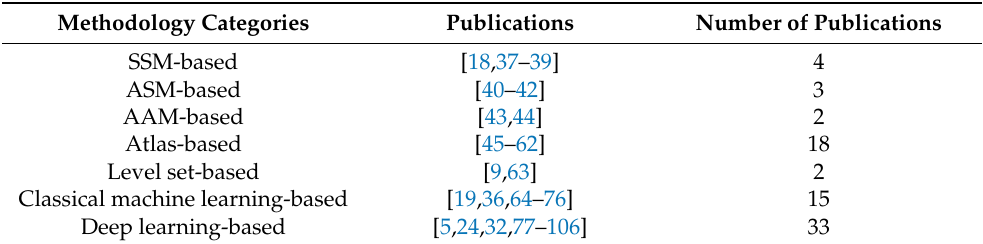
Table 2. Methodology applied to automatic mandible segmentation in the head and neck region, and the corresponding